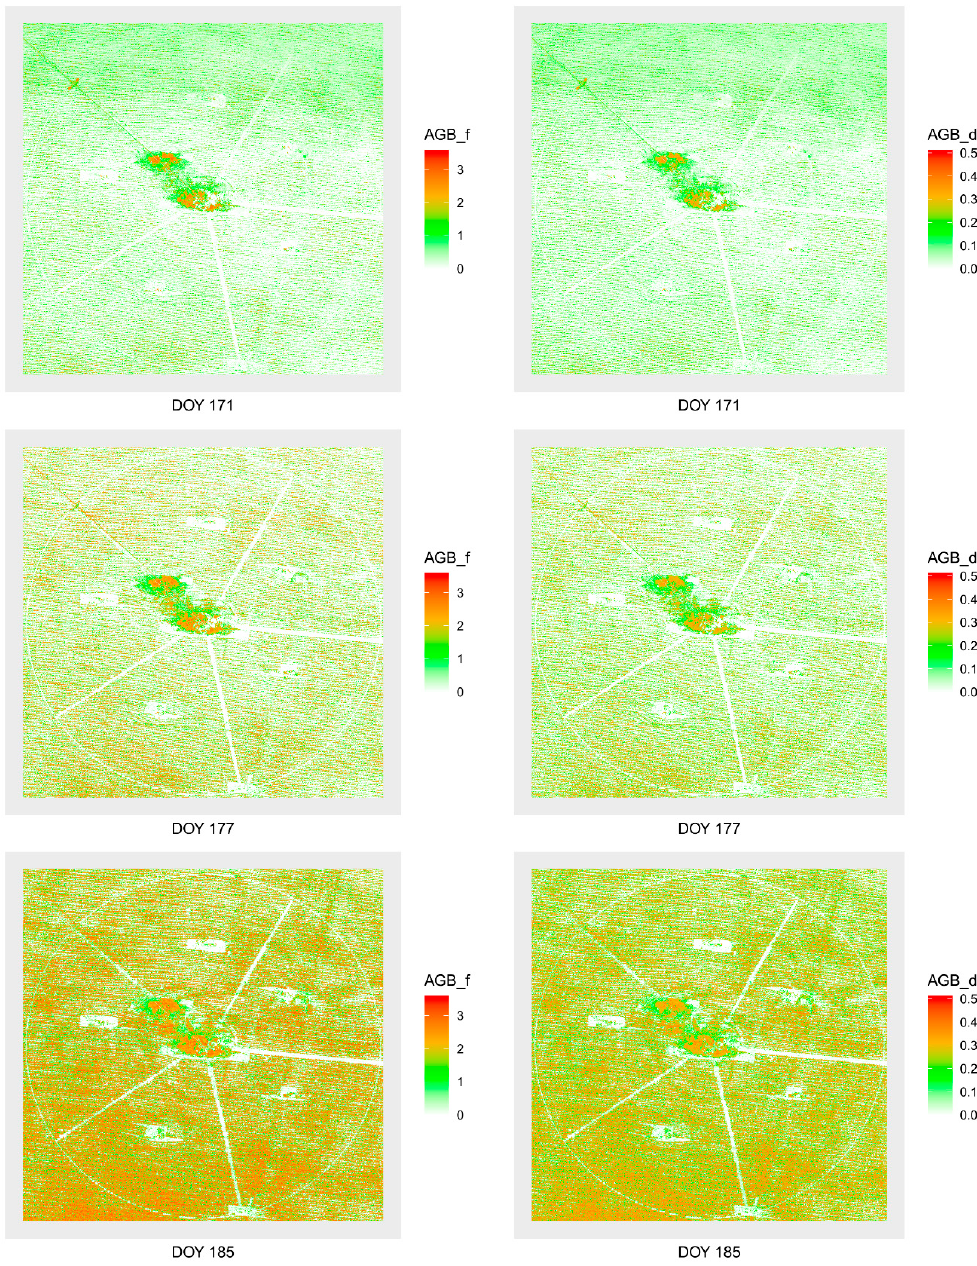
Figure 10. Maps of maize fresh and dry above-ground biomass based on vegetation indices derived from UAV RGB imagery for DOY 171, 177, and 185 in 2018. AGB_f and AGB_d are the abbreviations of maize fresh and dry above-ground biomass,